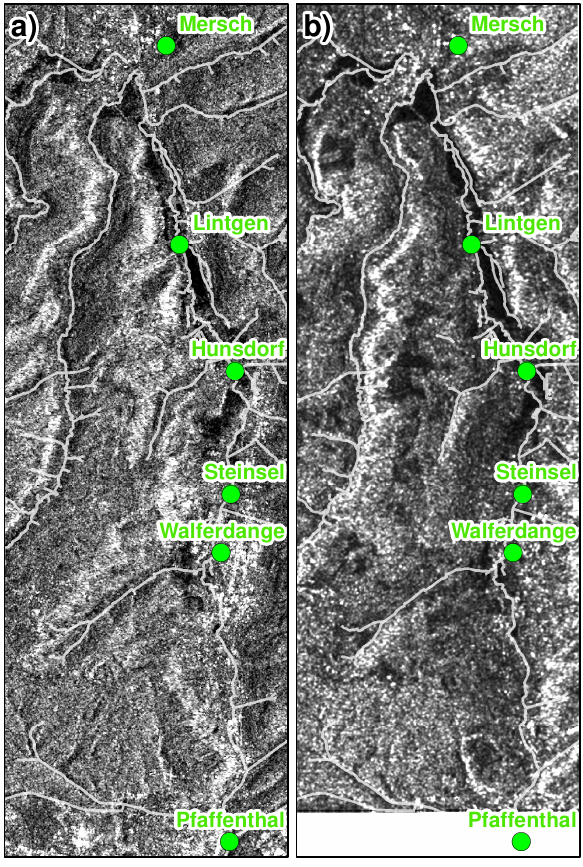
Fig. 2. The 2 available satellite images in backscatter values: (a) ERS-2 SAR image, (b) ENVISAT ASAR image. The hydromet- ric stations are also shown. In radar imagery, flooded areas appear in black colour due to the comparatively low signal return on open water